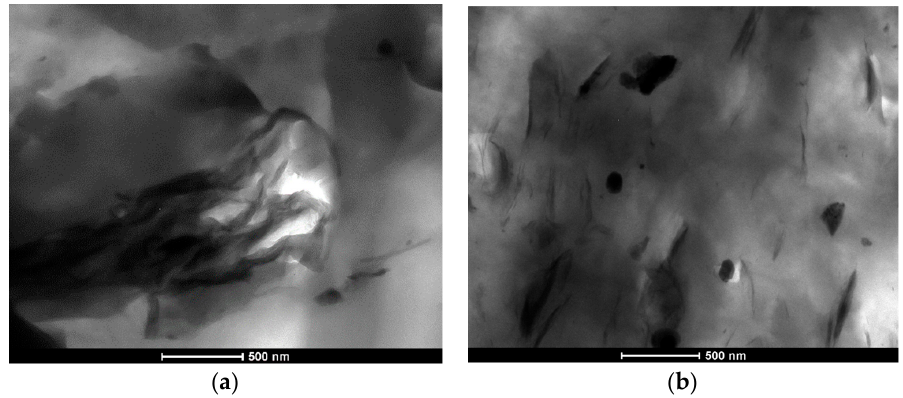
Figure 6. TEM images of ( a ) Fil-s A + 5% D67G and ( b ) Fil-s A + 5% PE/PP-g-MA +5% D67G. In fact, the presence of the PE/PP-g-MA additive allows a better dispersion of the nanofiller to be obtained, with smaller stacks of the layered silicate and some exfoliated platelets, compared with the system without the compatibilizer, which shows filler aggre- gates of micrometric size. These results are in line with the large scientific literature [23– 25] on virgin polymer-layered silicate nanocomposites that have highlighted the strict cor- relation existing between the dynamic shear rheological behavior of these composites and their nanostructure. Moreover, the typical transition from a liquid-like behavior of the pristine polymer matrices to a solid-like one for the corresponding nanocomposites, as a consequence of the strong interactions among nanoparticles and/or lamellar silicate-polymer chains, can also be observed in Figure 4c,c’, looking at the trends of the storage G’ and loss moduli G” for both the Fil-s hybrid systems. The structural network formed in well-dispersed nano- composites strongly affects the storage modulus (G’) since it is very responsive (in the low-frequency range) to the material morphological state, evidencing a reduced depend- ence on ω as the nanoplatelets dispersion degree increases. In this regard, it can be observed that the sample Fil-s A + 5% PE/PP-g-MA + 5% D67G shows the highest storage modulus values and the corresponding G’ and G” curves over- lap within the two low-frequency decades investigated, with G’ becoming higher at ω > 10 rad/s. Moreover, in order to quantitatively compare the effect of the formed nanostruc- ture on the storage modulus plots for all the samples analyzed, the G’ slopes at low angu- lar frequencies (known as the terminal regime) are reported in Table 4. Table 4. G’ slopes at low frequencies for both Fil-s A and Fil-s B systems. Sample G’ Slope 0.54 These data highlight that, even for the pristine recycled materials, the G’ slope devi- ates from the power-law dependence of two expected for a monodisperse entangled linear polymer melt in the terminal region, and it progressively becomes lower by adding the nanofiller, the compatibilizer and both of them. While the values of G’ slope for the neat Fil-s, lots can be related to a quite large polydispersity index, which is expected in the case